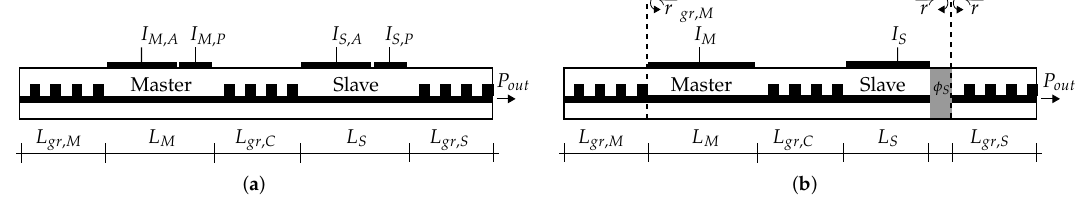
Figure 1. ( a ) Schematics of the coupled-cavity DBR laser. L M and L S are the sum of the lengths of the active and phase-control sections of the two laser cavities. The currents I M , A ( I M , P ) and I S , A ( I S , P ) are injected in the active (phase-control) sections of the master (left) and slave (right) laser cavities, respectively. ( b ) Analyzed coupled cavity. The phase tuning sections are replaced by a lumped phase term φ S . The right dashed line indicates the reference plane at which the equivalent reflectivities −→ r and ←− r are calculated using the transfer matrix